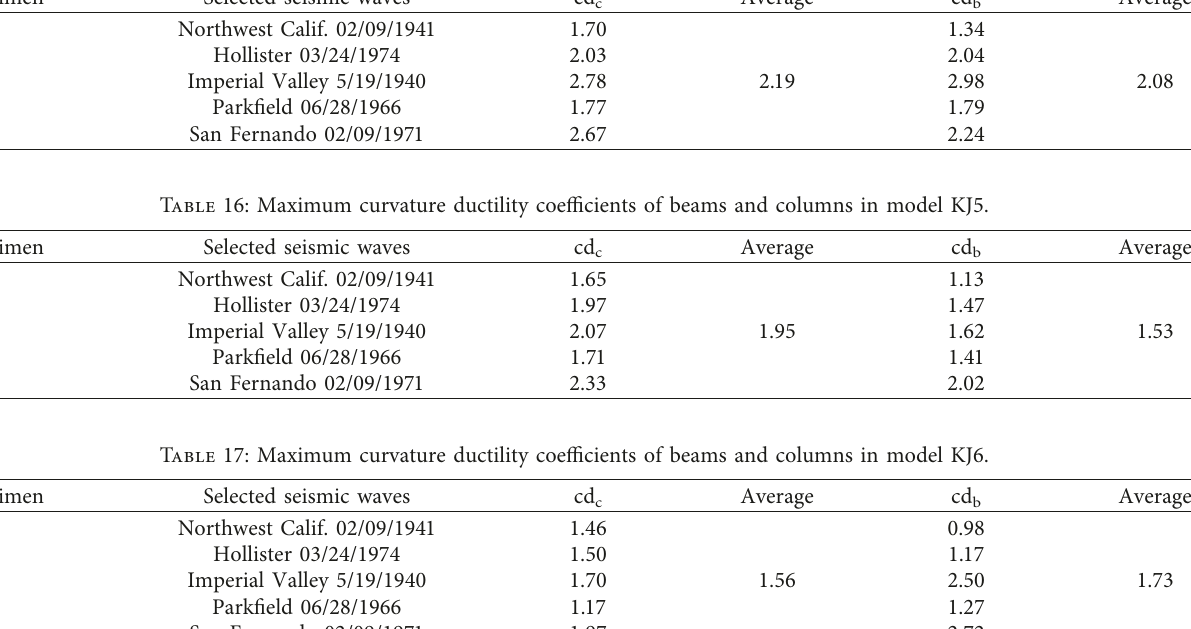
Table 15: Maximum curvature ductility coefficients of beams and columns in model KJ4. Specimen